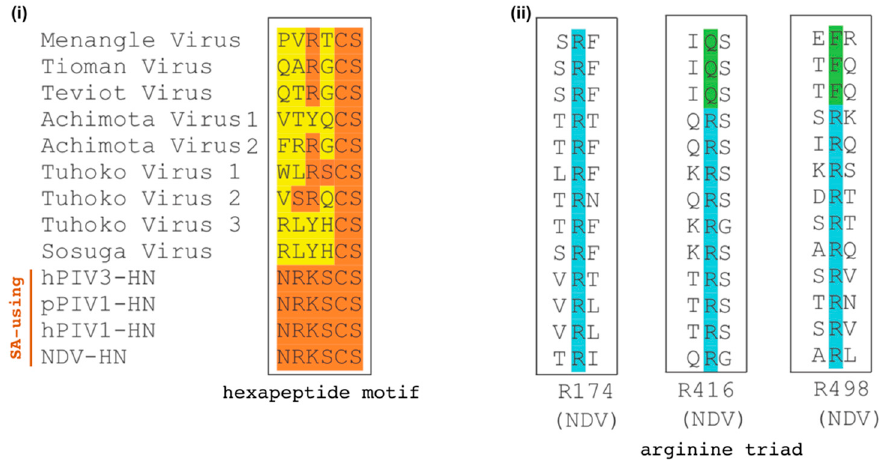
Figure 2. Parabulavirus receptor binding proteins (RBPs) lack motifs essential for binding and hydrolyzing sialic acid (SA). Hemagglutinin-neuraminidase (HN) proteins from known SA-using paramyxovirus (PMVs) human PIV3 (hPIV3-HN, NC_001796.2), porcine PIV-1 (pPIV1-HN, NC_025402.1), human PIV-1 (hPIV1-HN, NC_003461.1), and NDV (NDV-HN, NC_002617.1) were aligned with the RBP sequences from the genus Pararubulavirus , e.g., Menangle virus (NC_007620.1), Tioman virus (NC_004074.1), Teviot virus (NC_028233.1), Achimoto virus 1 (NC_025403.1), Achimoto virus 2 (NC_025404.1), Tuhoko virus 1 (NC_025410.1), Tuhoko virus 2 (NC_025348.1), Tuhoko virus 3 (NC_025350.1), and Sosuga virus (NC_025343.1) using ClustalW. Alignment reveals pararubulaviruses lack the conserved motifs required for sialic acid binding and neuraminidase functionality. These sequence motifs include: (i) the hexapeptide NRKSCS and (ii) a triarginyl cluster.